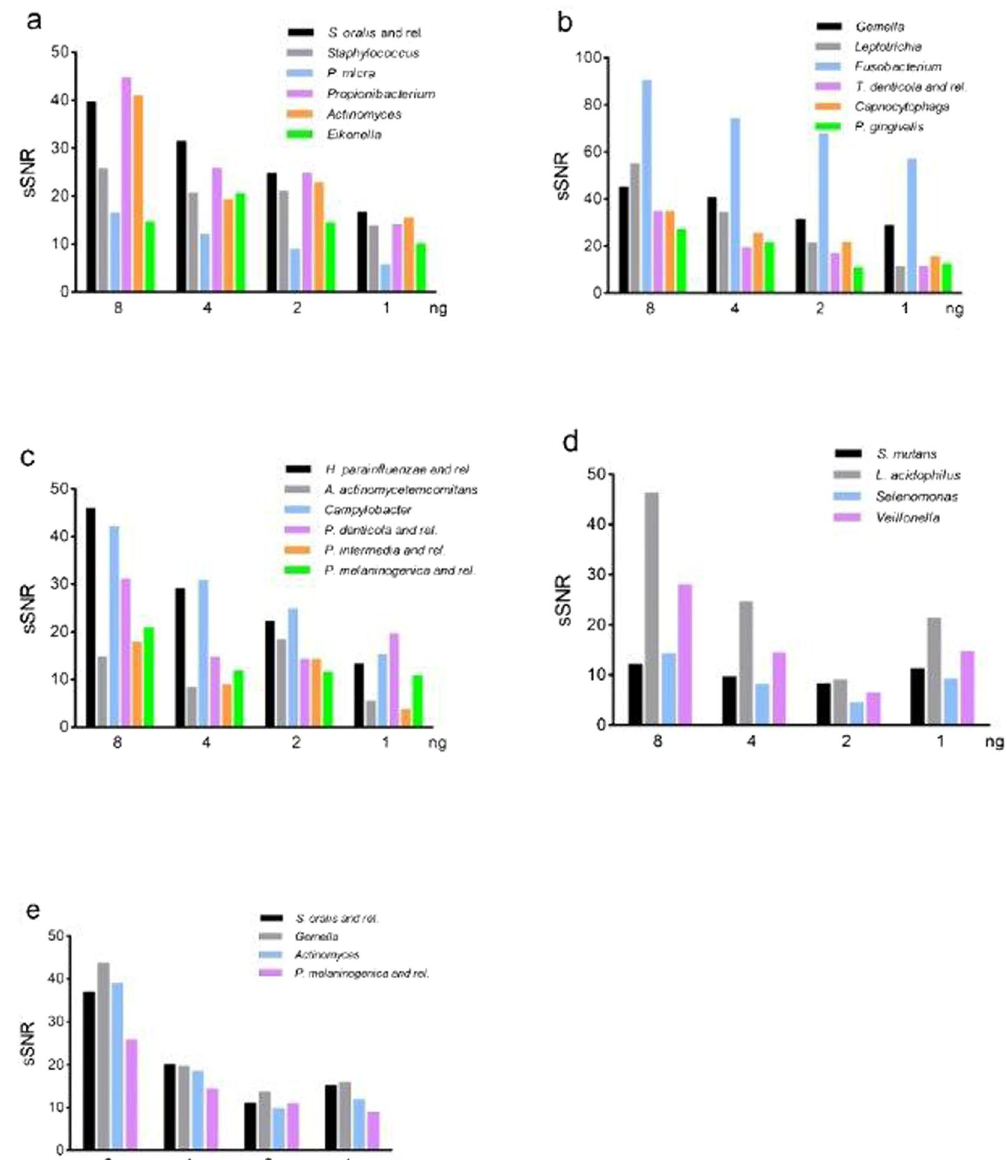
Figure 2. Sensitivity of the OralArray on DNA mixes. Artificial mixes of 16 S rRNA amplicons were subjected to LDR-UA analysis, sSNR values were plotted vs ng of each DNA amplicon. sSNR values were obtained with decreasing amounts of DNA mixes containing: ( a ) S. oralis, S. aureus, P. micra, P. acidifaciens, A. odontolyticus , and E. corrodens 16 S rRNA amplicons (8–1 ng each); ( b ) G. morbillorum, L. buccalis, F. nucleatum, T. denticola, C. sputigena , and P. gingivalis 16 S rRNA amplicons (8–1 ng each); ( c ) H. parainfluenzae, A. actinomycetemcomitans, C. sputorum, P. denticola, P. intermedia , and P. melaninogenica 16 S rRNA amplicons (8–1 ng each); ( d ) S. mutans, L. acidophilus, S. noxia , and V. parvula 16 S rRNA amplicons (8–1 ng each); ( e ) S. oralis, G. morbillorum, A. odontolyticus , and P. melaninogenica 16 S rRNA amplicons (8–1 ng each) added with human genomic DNA up to 100 ng of total DNA (68–96